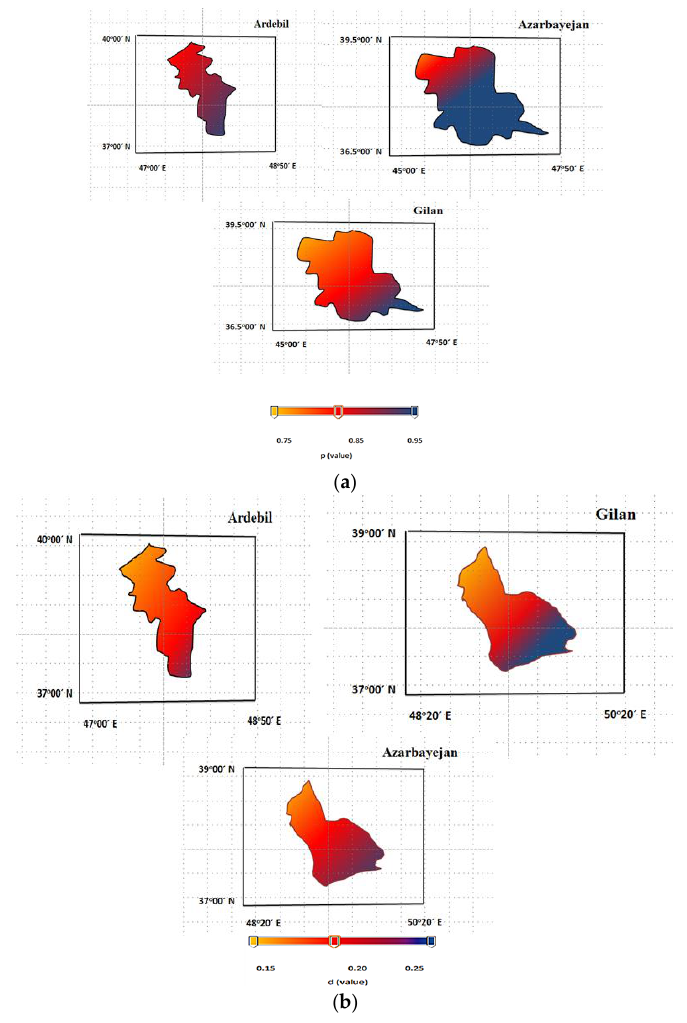
Figure 10. The zoning maps for the provinces based on uncertainty of data based on ( a ) p factor and ( b ) d value.